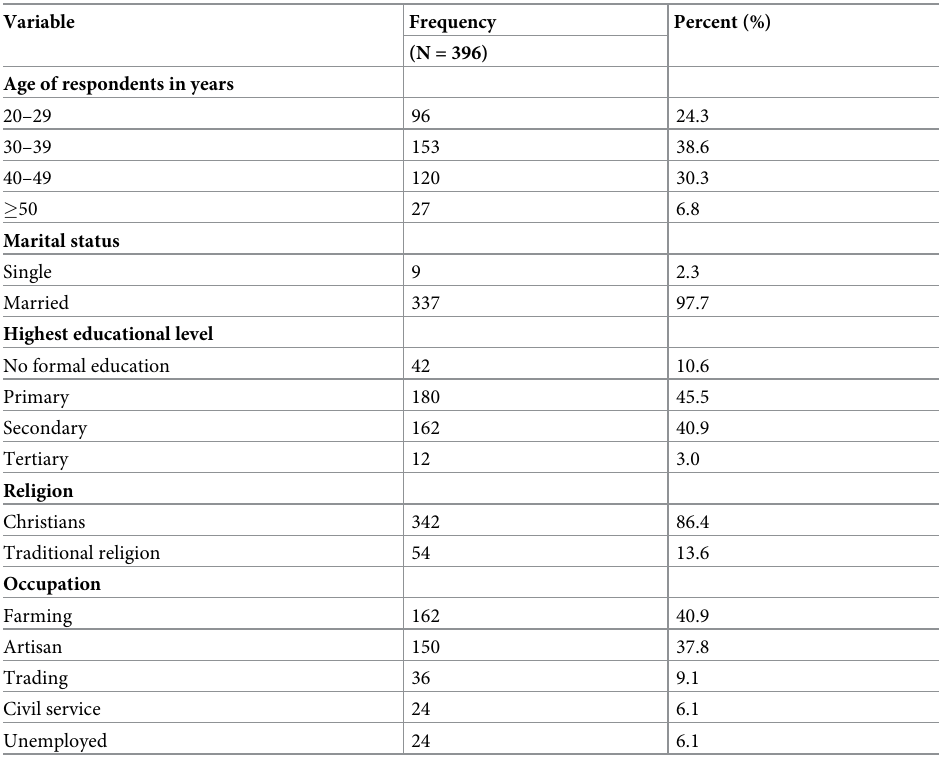
Table 1. Socio-demographic characteristics of men in rural Ebonyi